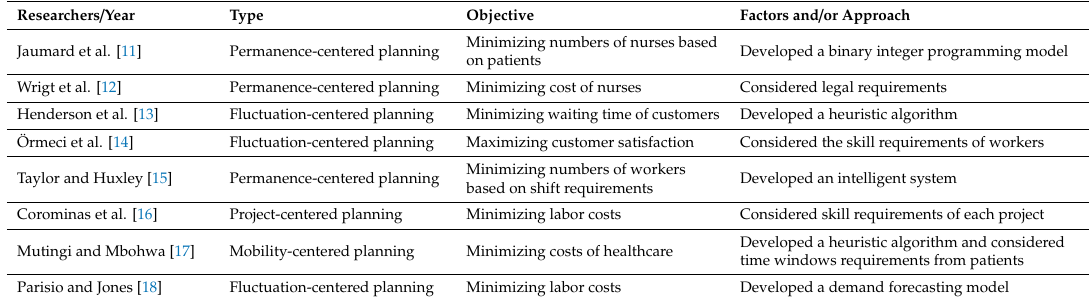
Table 2. Summary of Personnel Scheduling